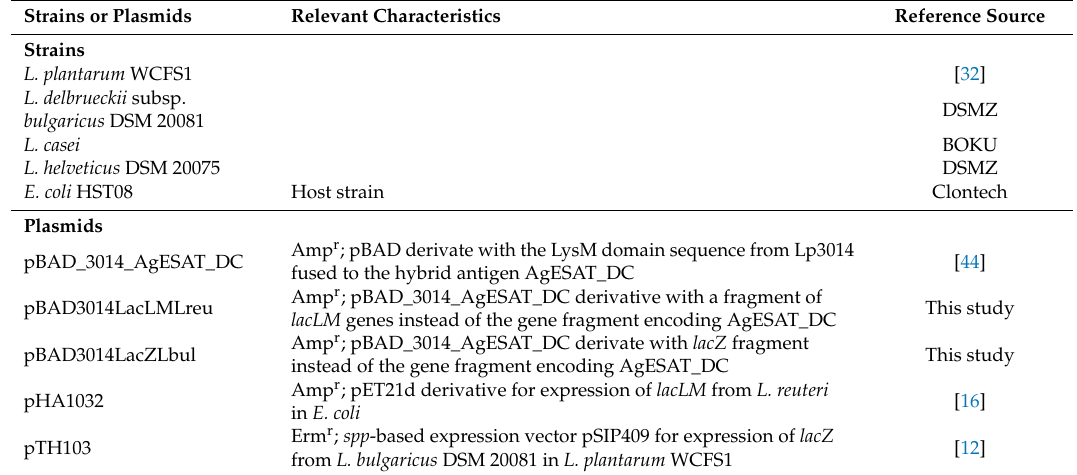
Table 4. Strains and plasmids used in the